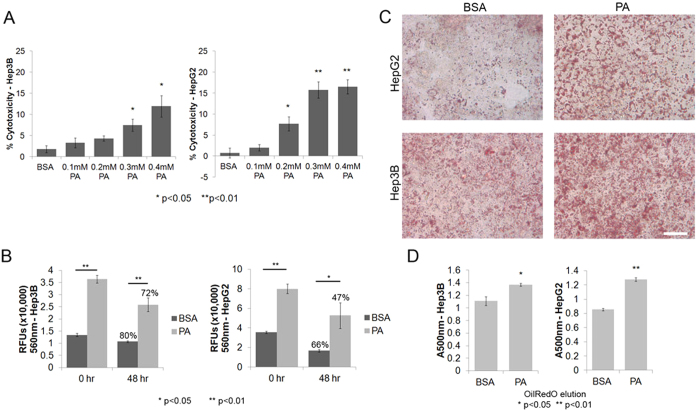
Cytotoxicity vs. metabolic activity.(A) Bar graph showing average cytotoxicity (±SEM) determined using LDH assay in HepG2 or Hep3B cells following 5 day (with serum) and 2 day (without serum) treatment with BSA or PA at different concentrations (n = 3). P-values indicate significance levels comparing average LDH release in PA treated cells with BSA treated cells determined by Student’s t-test (two tailed). (B) Bar graph showing the relative metabolic activity represented by average fluorescence (±SEM) from reduced AlamarBlue reagent (resazurin) in HepG2 or Hep3B cells following 5 day treatment (with serum) and 2 day (without serum) with BSA or PA (n = 3). P-values indicate significance levels determined by Student’s t-test (two tailed). Numbers above bars indicate the percentage of proliferating cells at 48 hours compared to 0 hours. (C) Neutral lipids and fatty acids in HepG2 or Hep3B cells were stained with Oil Red O following 5 day (with serum) and 2 day (without serum) treatment with BSA or PA. Bright-field microscopy images were recorded at 40× magnification (scale bar = 50 μm). (D) Relative levels of lipids and fatty acids in BSA and PA treated cells were quantified by eluting the Oil Red O dye and measuring relative absorbance at 500 nm. Bar graph shows average absorbance (±SEM) in BSA and PA treated cells. P-values indicate significance levels comparing average absorbance in BSA or PA treated cells determined by Student’s t-test (two tailed).